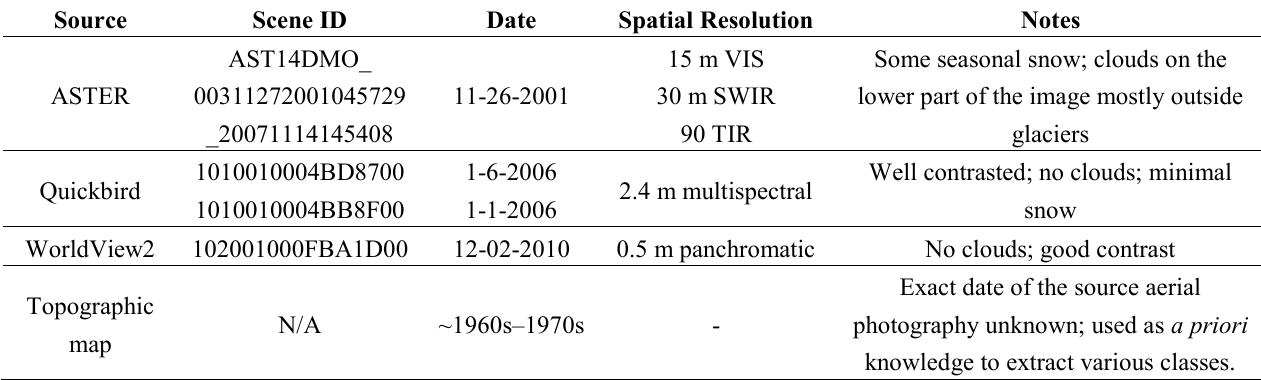
Table 1. Summary of the data sources used in this